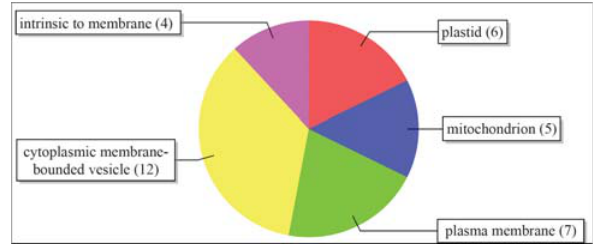
Figure 2 - Distribution of GO terms in the Cellular Component category, level 3.